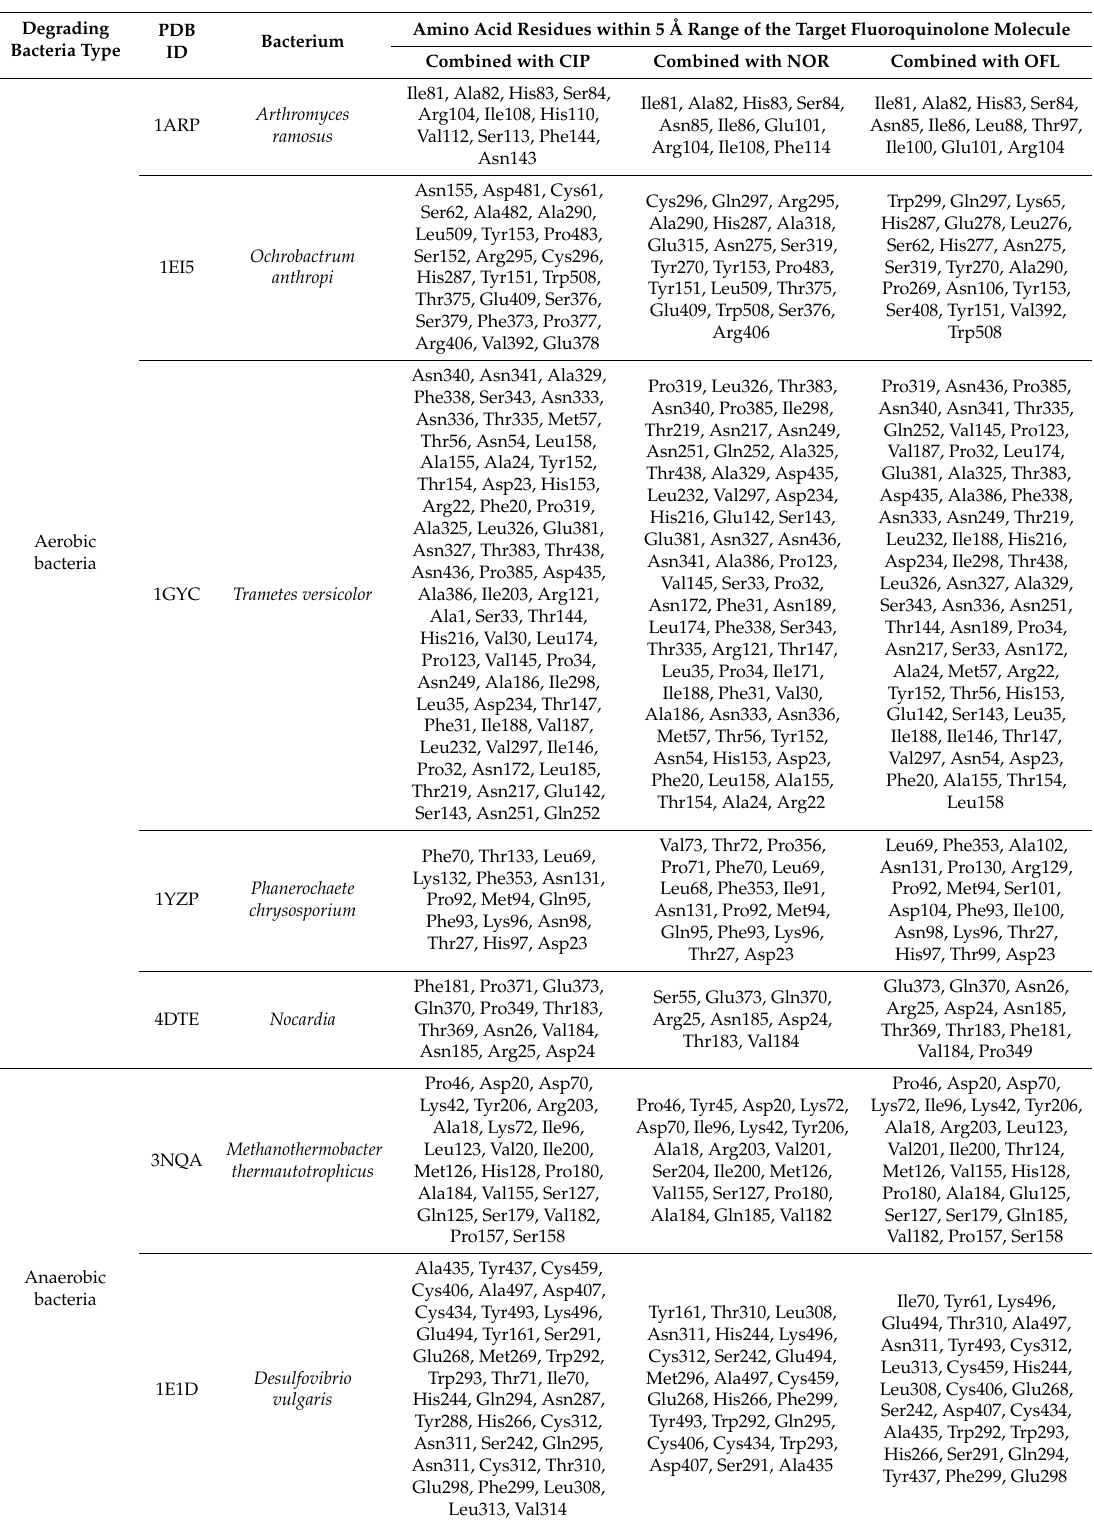
Table 1. Statistics of amino acid residues within 5 Å range of the target fluoroquinolone